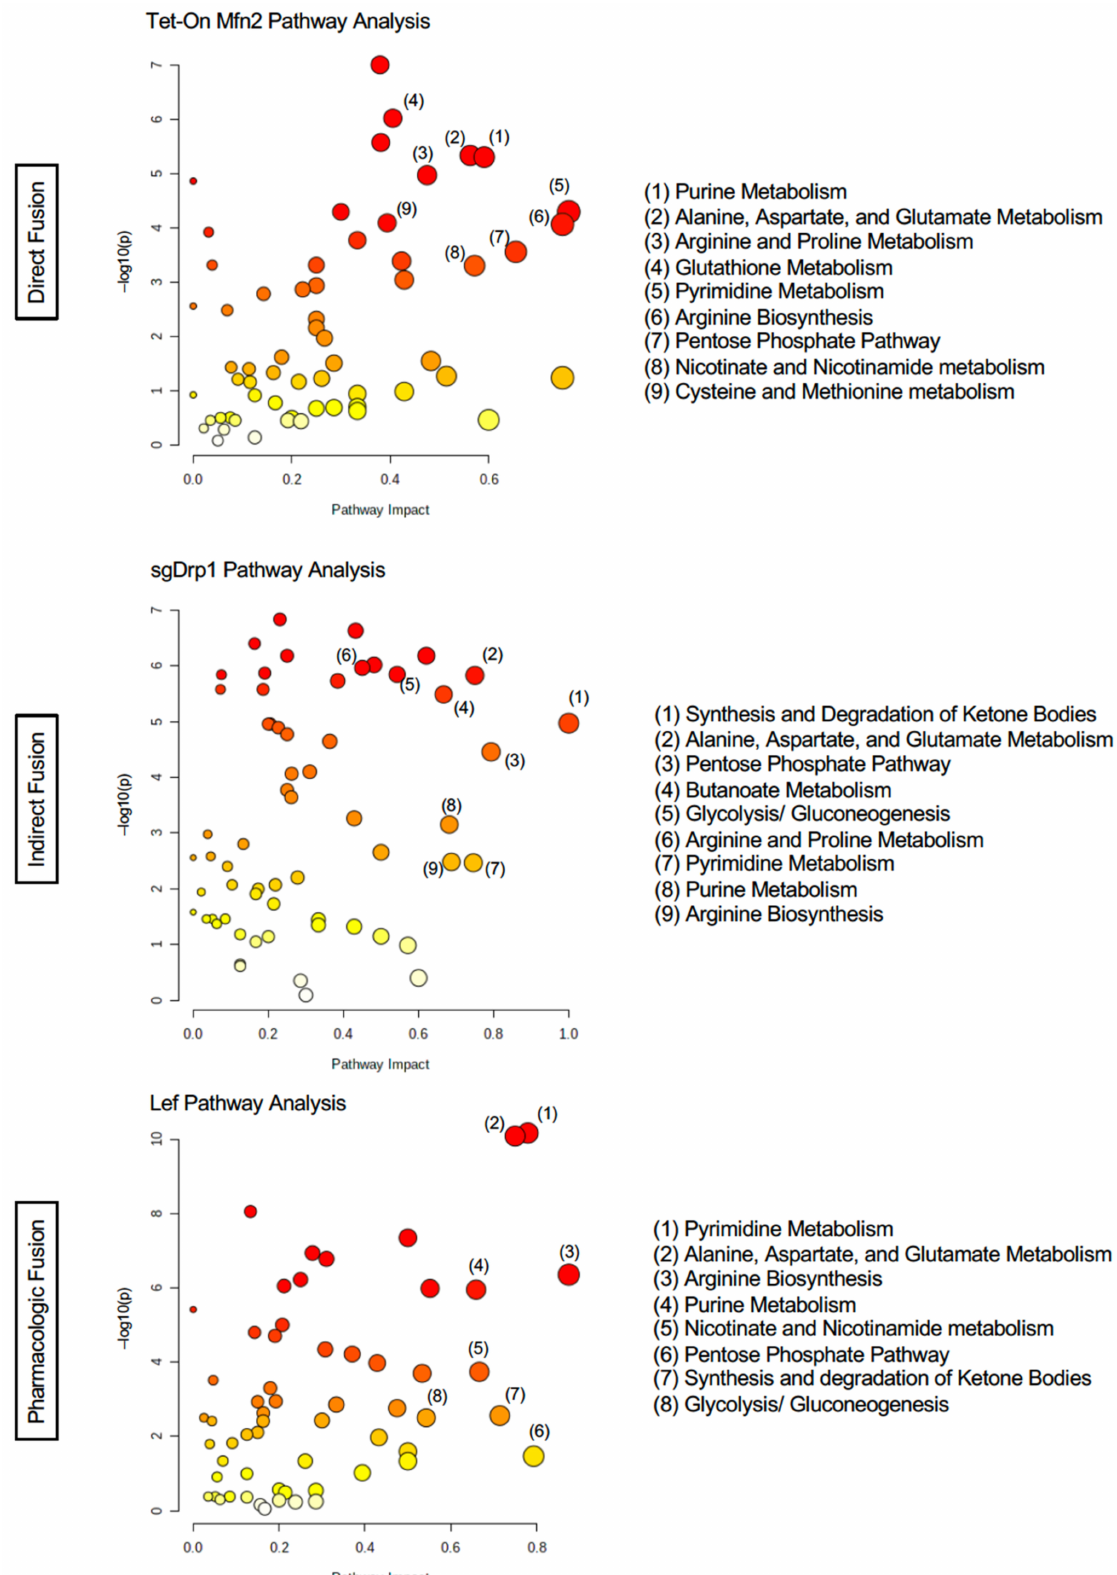
Figure 4. Total pathway analysis of filtered metabolites reveals similar impact of Amino Acid, Nucleotide, and Carbohydrate metabolism pathways as a function of mitochondrial fusion: Tet-On Mfn2 (direct), sgDrp1 (indirect), and leflunomide treatment